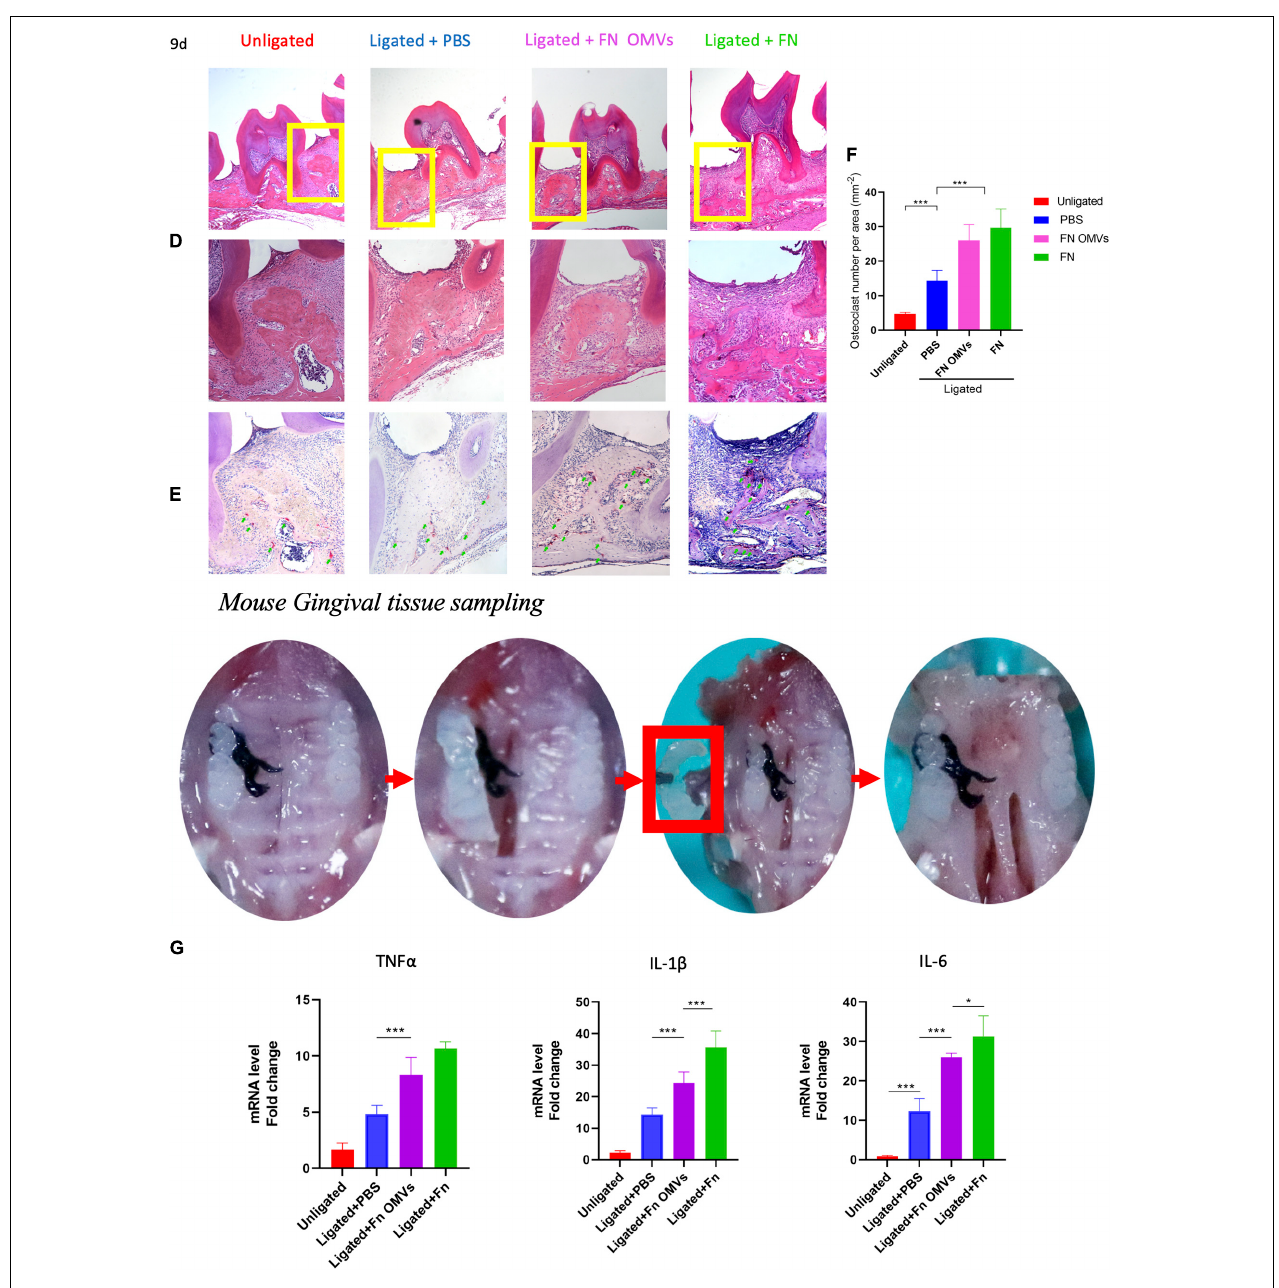
FIGURE 4 | Fusobacterium nucleatum OMVs aggravate periodontitis and alveolar bone loss in a mouse model. (A) The periodontitis mouse model was constructed, and the mice were divided into four experimental groups: a non-ligation group, ligation + PBS group, ligation + F. nucleatum OMV group and ligation + F. nucleatum group. The detailed scheme is shown in the section “Materials and Methods”. (B,C) Micro-CT images of the mouse maxillas showed more extensive alveolar bone loss and reductions in alveolar bone density. Quantitative analysis of the BV/TV (B) and CEJ-ABC distances (C) as determined by micro-CT. (D–F) Histological images of H&E and TRAP staining. The extent of alveolar bone loss in periodontal tissue (D) and quantitative analysis of osteoclasts (E,F) are shown. (G) Expression of inflammatory factors (IL-1 β , IL-6, and TNF- α ) in corresponding mouse gingival tissues. The data are presented as the mean ± SD. Significant differences between the groups, * P < 0.05, ** P < 0.01, *** P < 0.001. CEJ, cement-enamel junction; ABC, alveolar bone crest; BV/TV, bone volume/total